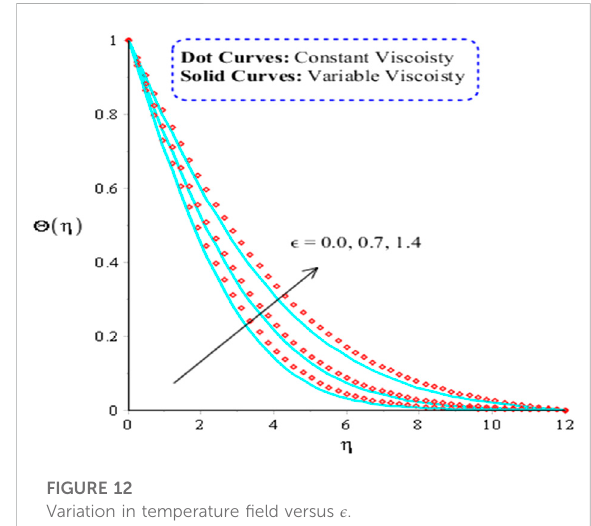
FIGURE 12 Variation in temperature fi eld versus ϵ .